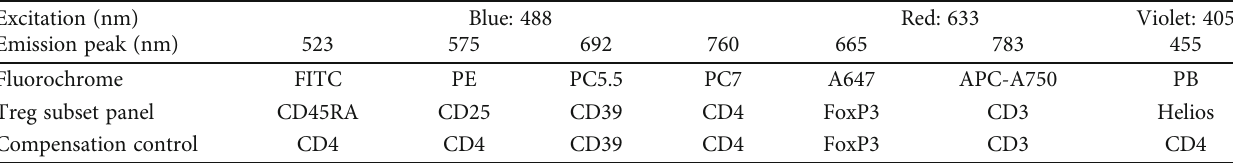
Table 1: Overview of the Treg subset panel dedicated to a speci fi c cell type which is indicated by individual colors. Excitation